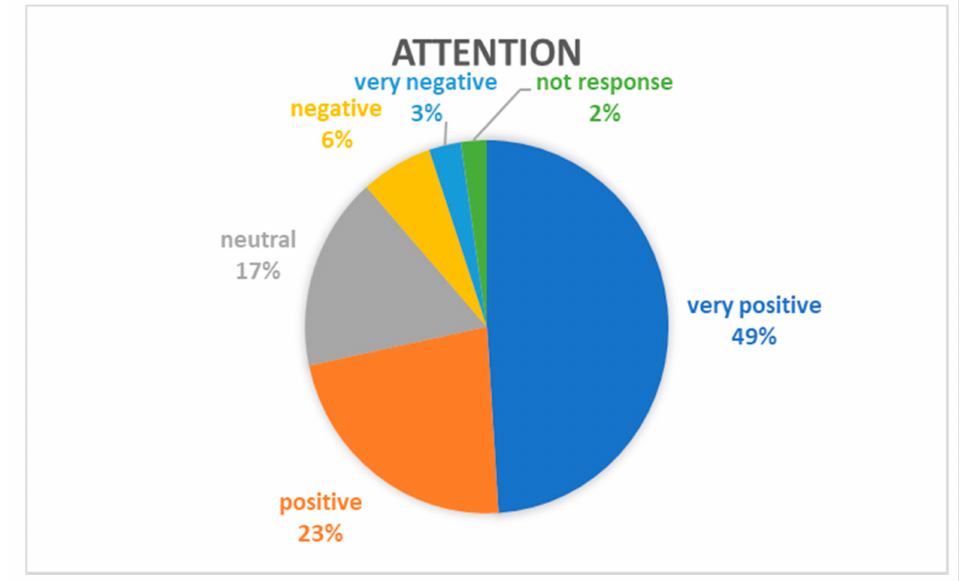
Figure 3. Graph of the average response to the attention dimension